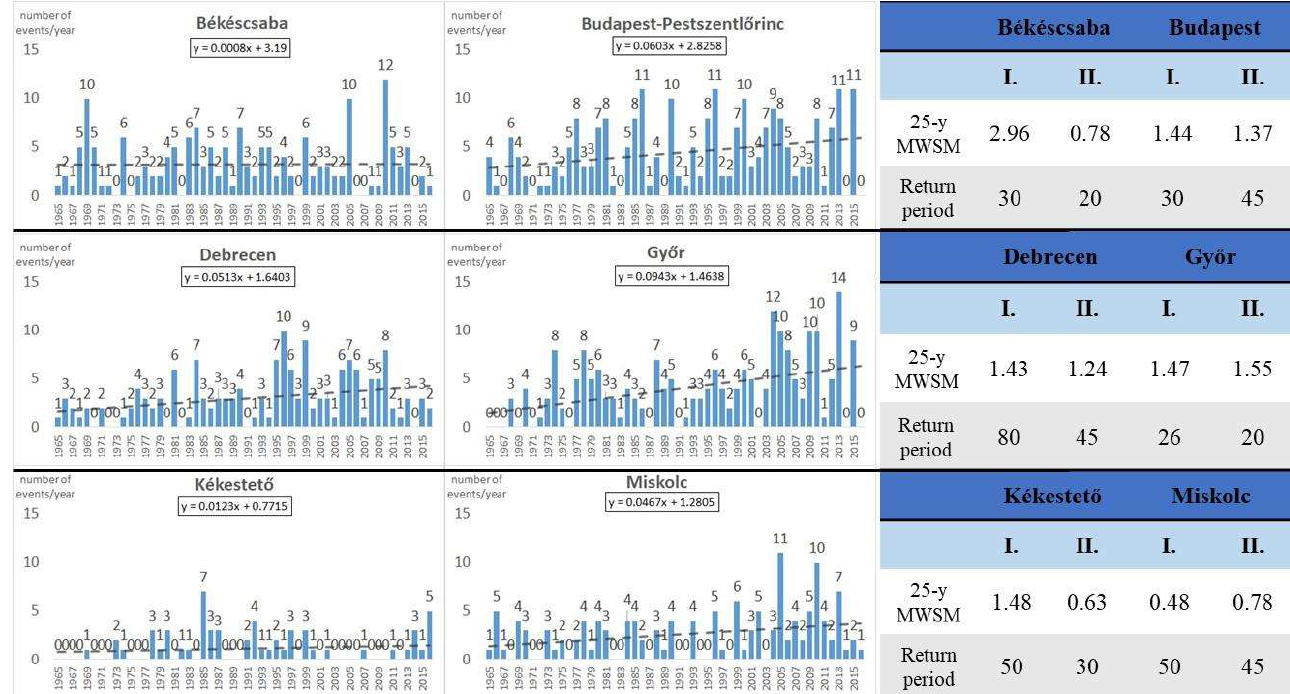
Figure 8. Annual Number of Cases (ANC) of wet snow events between 1965–2016 with a linear trend line (dotted line) and its equation ( left ) and the 25-year Maximum Wet Snow Mass (MWSM) (kg·m −1 ) and its Return period in the 1965–1990 period (Column I.) and in the 1991–2016 period (Column II.) ( right ) in Pápa, Pécs, Siófok, Szeged, Szolnok, Szombathely.